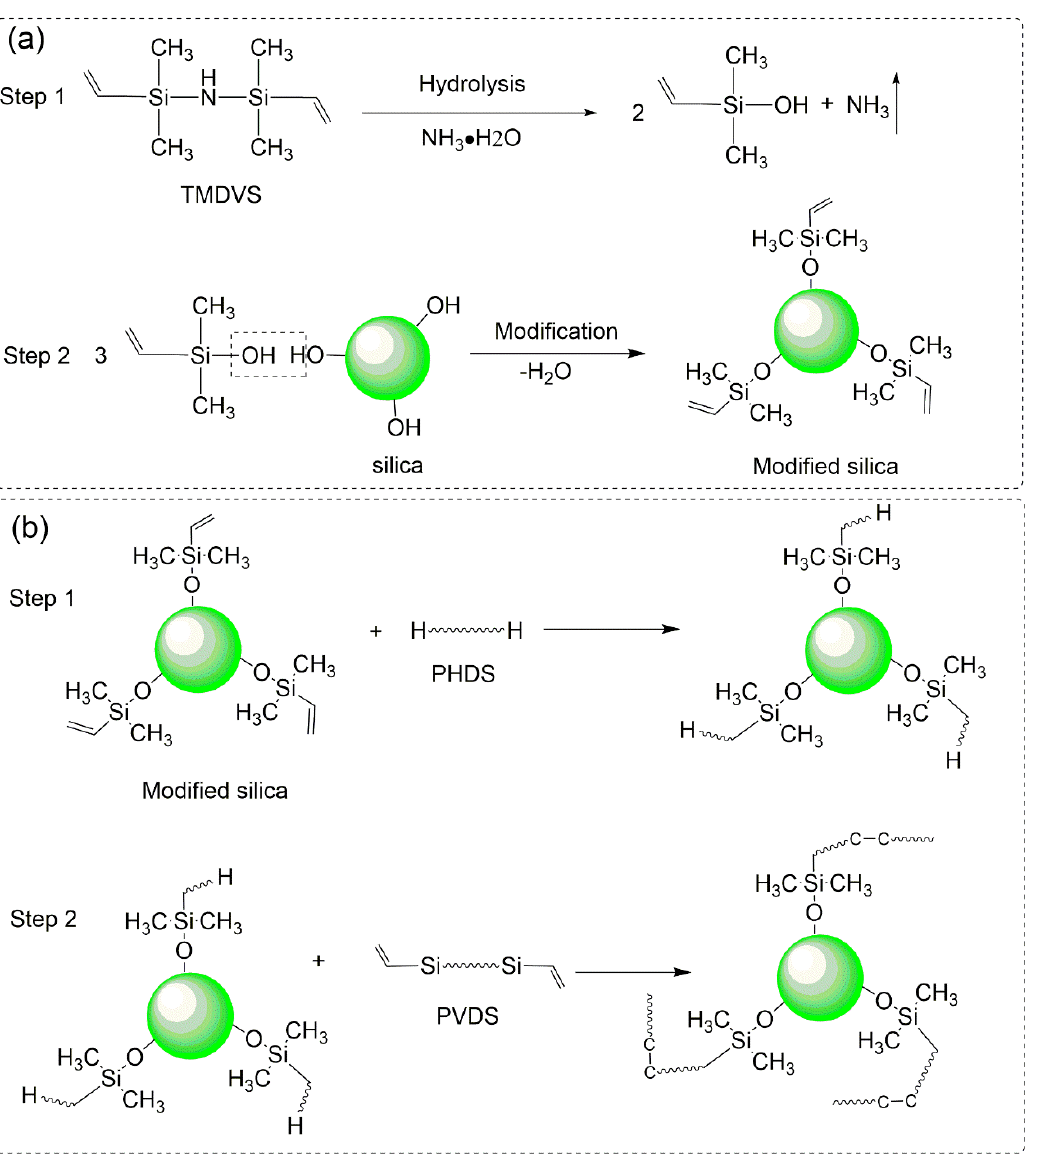
Figure 1. Schematic diagram of ( a ) TMDVS modification process on silica surface; ( b ) mechanism of in situ polymerization between f -SiO 2 and SR matrix.